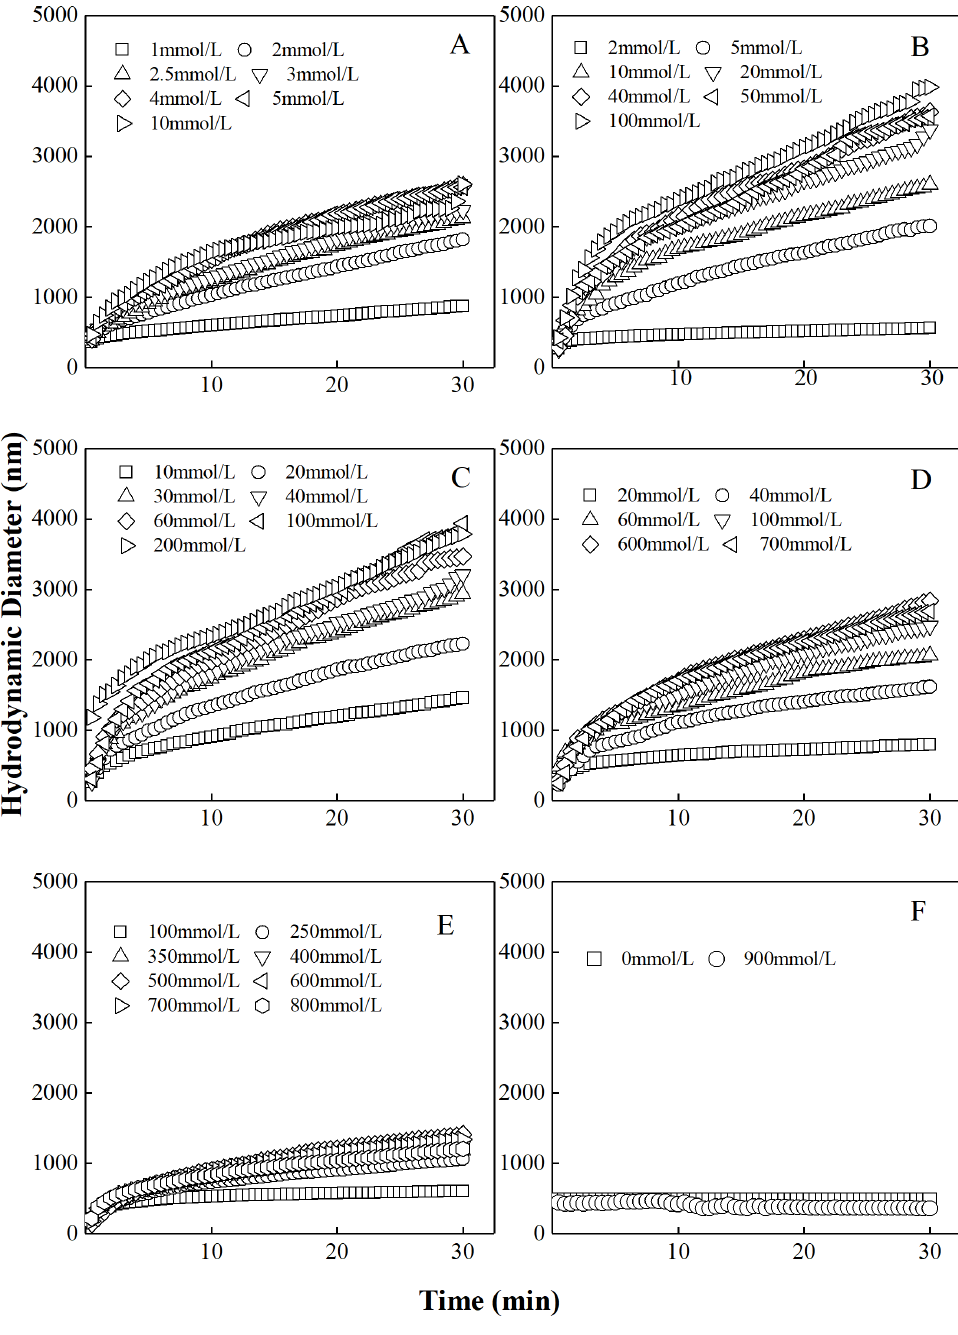
Figure 1 Growth of hydrodynamic diameters of ‘‘100%kaolinite (A), 96.67% kaolinite + 3.33% P. putida (B), 93.33% kaolinite + 6.67% P. putida (C), 83.33% kaolinite + 16.67% P. putida (D), 66.67% kaolinite + 33.33% P. putida (E), 100% P. putida (F)" aggregates in LiNO 3 solutions. Full-size DOI: